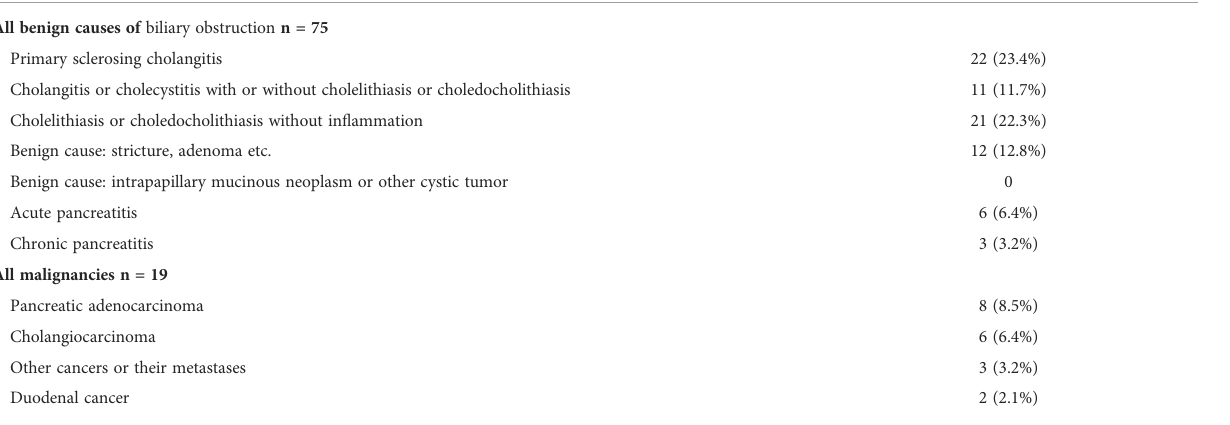
TABLE 2 Pathology categorizations used in the fi nal analysis in all patients.